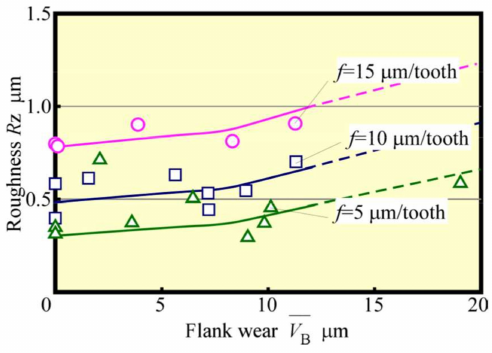
Figure 14. Relationship between cutting force and flank wear (Up cut, N s = 100,000 min − 1 ) ( a ) Normal cutting force ( b ) Tangential cutting force.